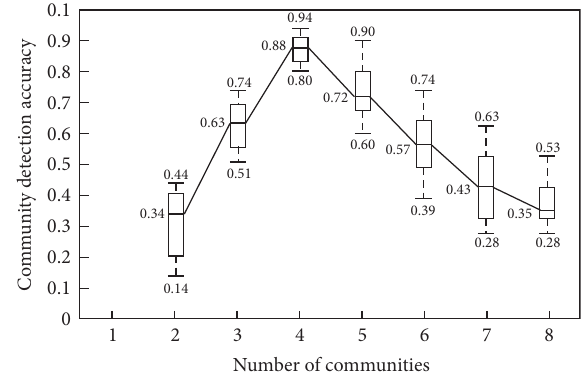
Figure 11: Box plot of model parameter sensitivity